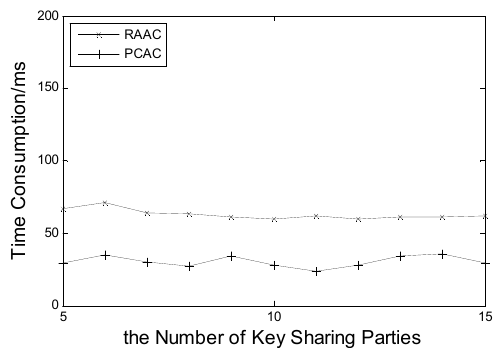
Figure 8. Time Consumption in the Act_Audit Phase.